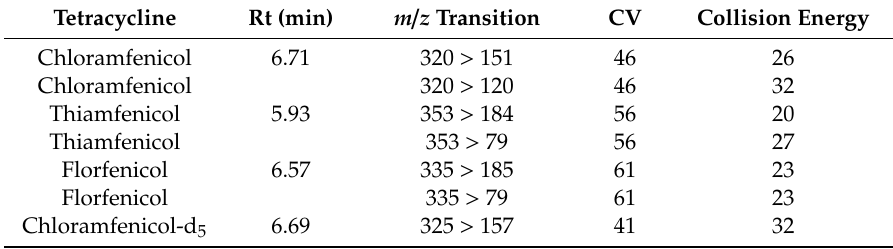
Figure 2. MRM chromatograms of feed samples spiked with amfenicols at the validation level of 200 µg/kg. Table 1. Retention time (Rt), cone voltage (CV), collision energy, and precursor and product ions employed for ion identification.